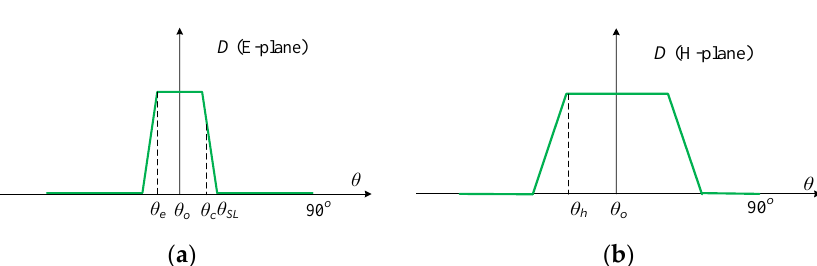
Figure 3. Graphical representation of the array radiation pattern mask along the ( a ) E-plane and ( b ) H-plane.